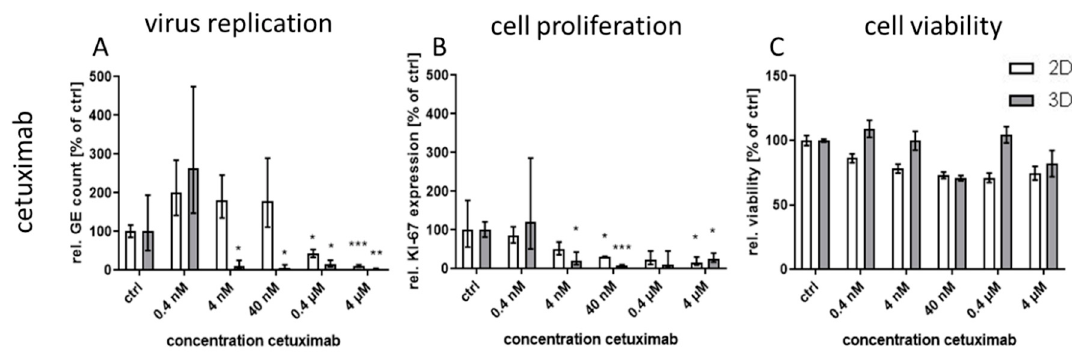
Figure 4. Effect of cetuximab treatment on CPXV infection in primary 3D and 2D cultures. NHEK were grown on decellularized extracellular matrix and infected with CPXV. Infected cells were treated with five concentrations ( n = 3) of cetuximab. At 48 h p.i. viral GE were quantified via qPCR and described as GE per cell. All RTKI-treated samples were normalized to infected untreated controls ( A ). Expression of the cellular proliferation marker KI-67 ( B ) was determined via qPCR, normalized to the cellular reference gene MYC , and expressed relative to the untreated controls. Statistical significance of reduction relative to the respective controls was calculated by two-tailed Student’s t -test (* p < 0.05, ** p < 0.01, *** p < 0.001). Cell viability was determined by ATP measurement with the cell viability assay CellTiter-Glo ® (Promega). Infected but untreated controls ( n = 2) were taken as 100%. Ratios of treated samples ( n = 2) to corresponding controls are illustrated as relative viability ( C ).